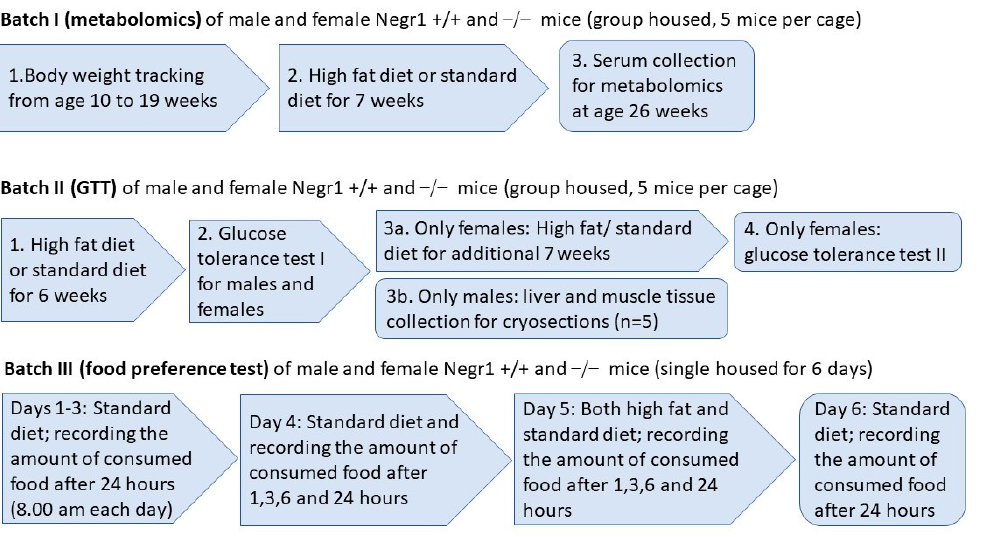
Figure 1. Schematic overview of the batches of mice and tests conducted in the current study. The age of Batch II and Batch III mice was around 12 weeks in the beginning of the experiments.